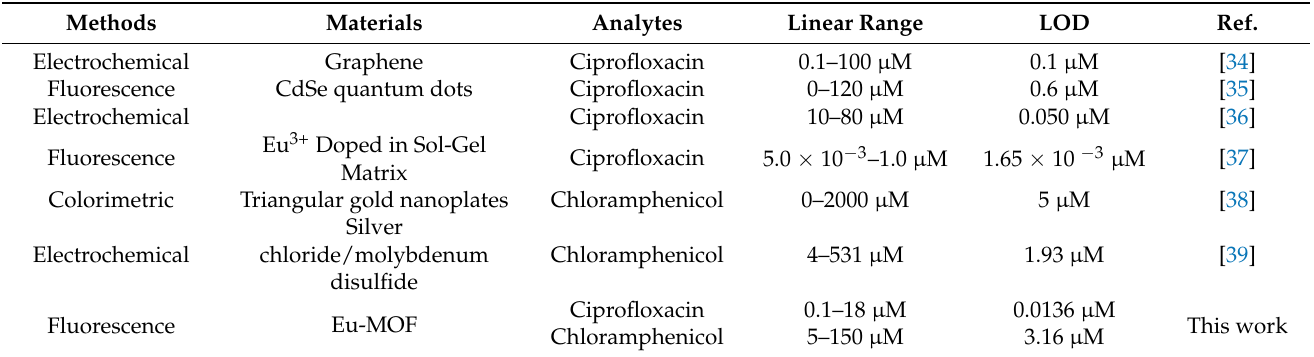
Figure 4. ( A ) Fluorescence spectra and ( B ) standard curve of Eu-MOF under the addition of different concentrations of ciprofloxacin; Inset of ( A ): optical images of fluorescent sensor after addition of different concentrations of ciprofloxacin in centrifuge tubes under a UV lamp at 254 nm; ( C ) fluo- rescence spectra and ( D ) standard curveof Eu-MOF under the addition of different concentrations of chloramphenicol; Inset of ( C ): optical images of fluorescent sensor after addition of different concentrations of chloramphenicol in centrifuge tubes under a UV lamp at 254 nm. Table 1. The comparison of Eu-MOF with other methods for CIP and CHL detection.